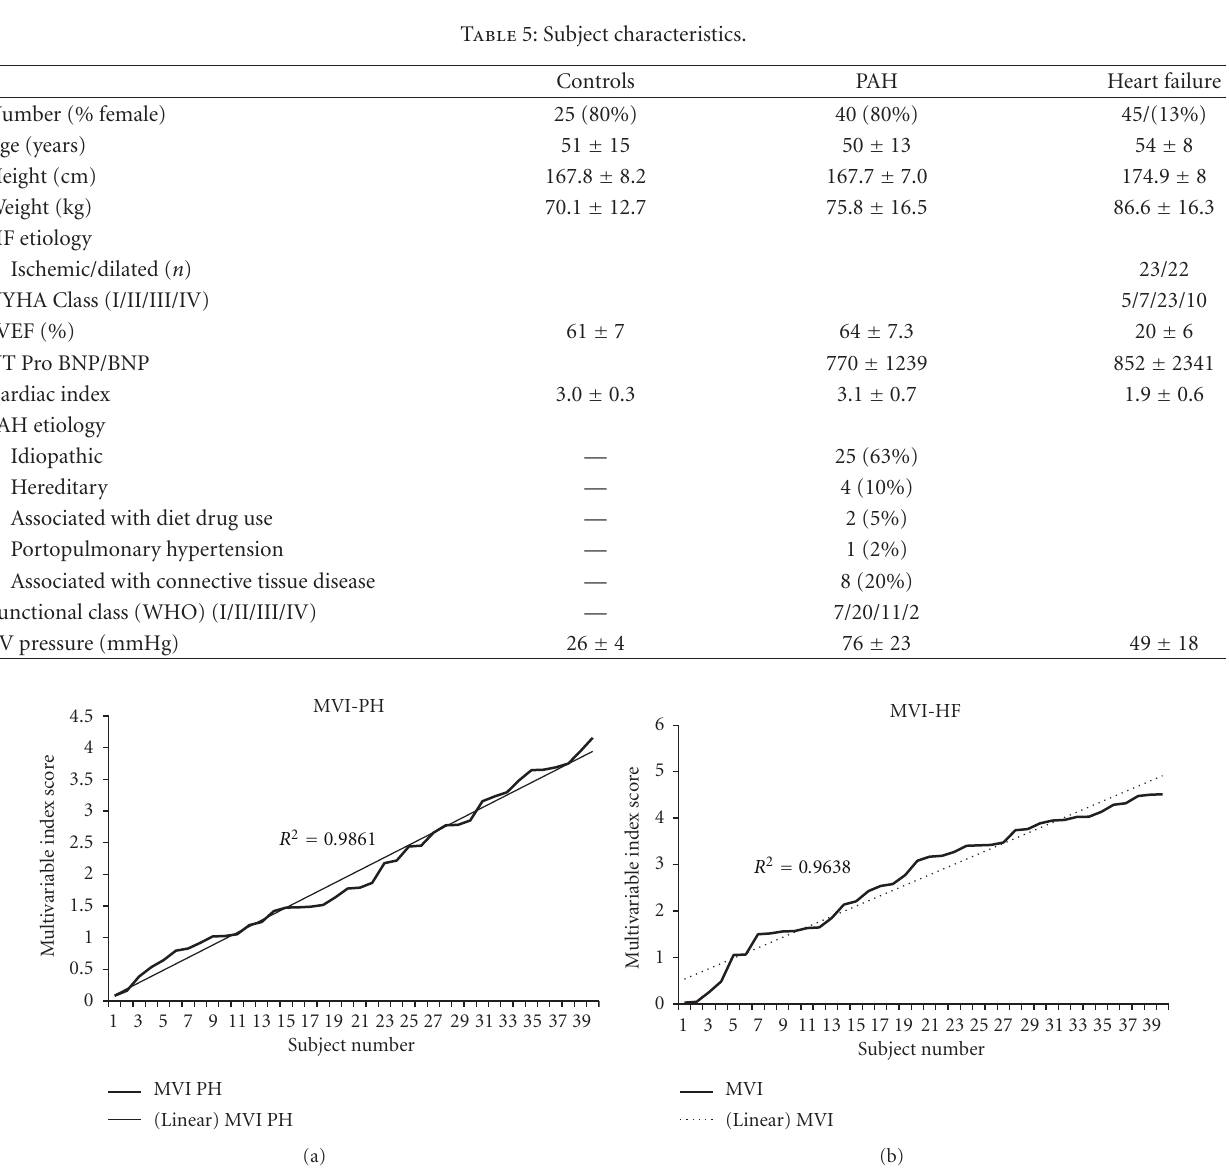
Figure 1: MVI score sorted and plotted for each subject for PAH and HF populations showing the score to be a continuous variable. patients with less significant relationships between these gas exchange measures and NYHA or WHO